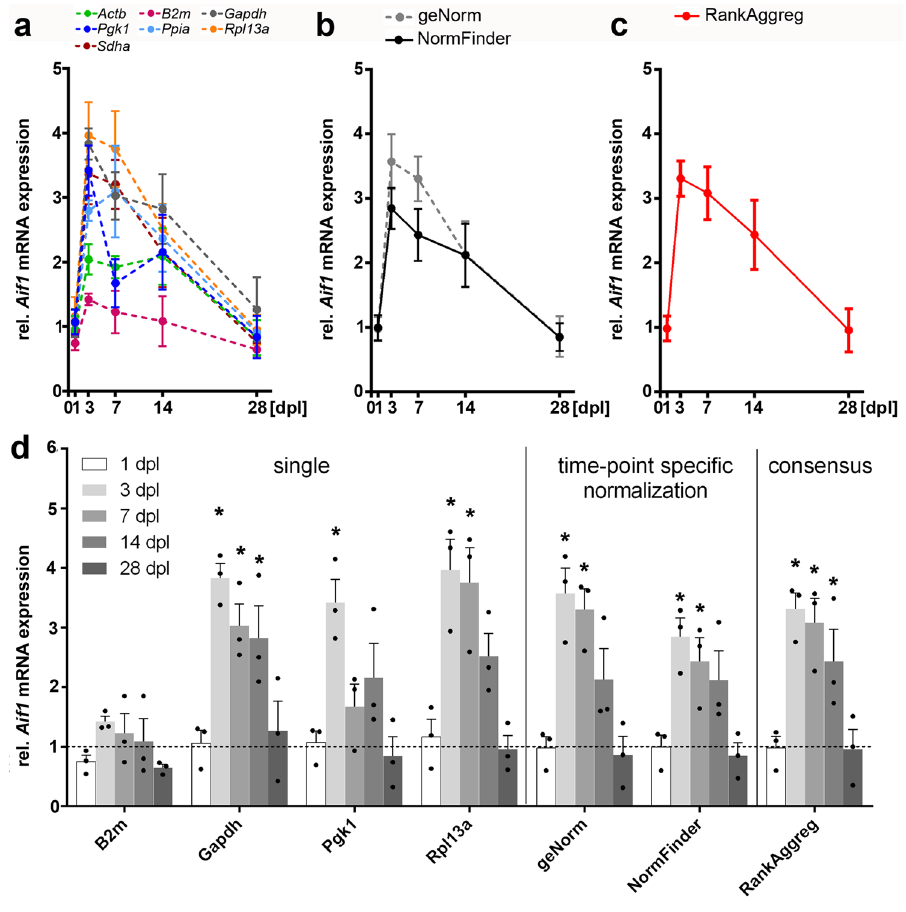
Figure 8. Influence of different normalization strategies for accurate quantification of Aif1 mRNA expression levels in the dentate outer molecular layer after entorhinal denervation. ( a , d ) Normalization using a single reference gene resulted in different Aif1 mRNA expression pattern in the dentate outer molecular layer after entorhinal denervation. ( b , d ) Normalization using reference genes determined by geNorm or NormFinder showed comparable time courses and pattern of Aif1 mRNA expression levels. ( c , d ) Results from both algorithms were analyzed using RankAggreg to obtain a consensus ranking for the entire lesion period. dpl, days post lesion. Data are shown as mean ± SEM. N = 3 animals per time point. Statistics: One-way ANOVA, followed by Dunnett’s post-hoc test, with * p <